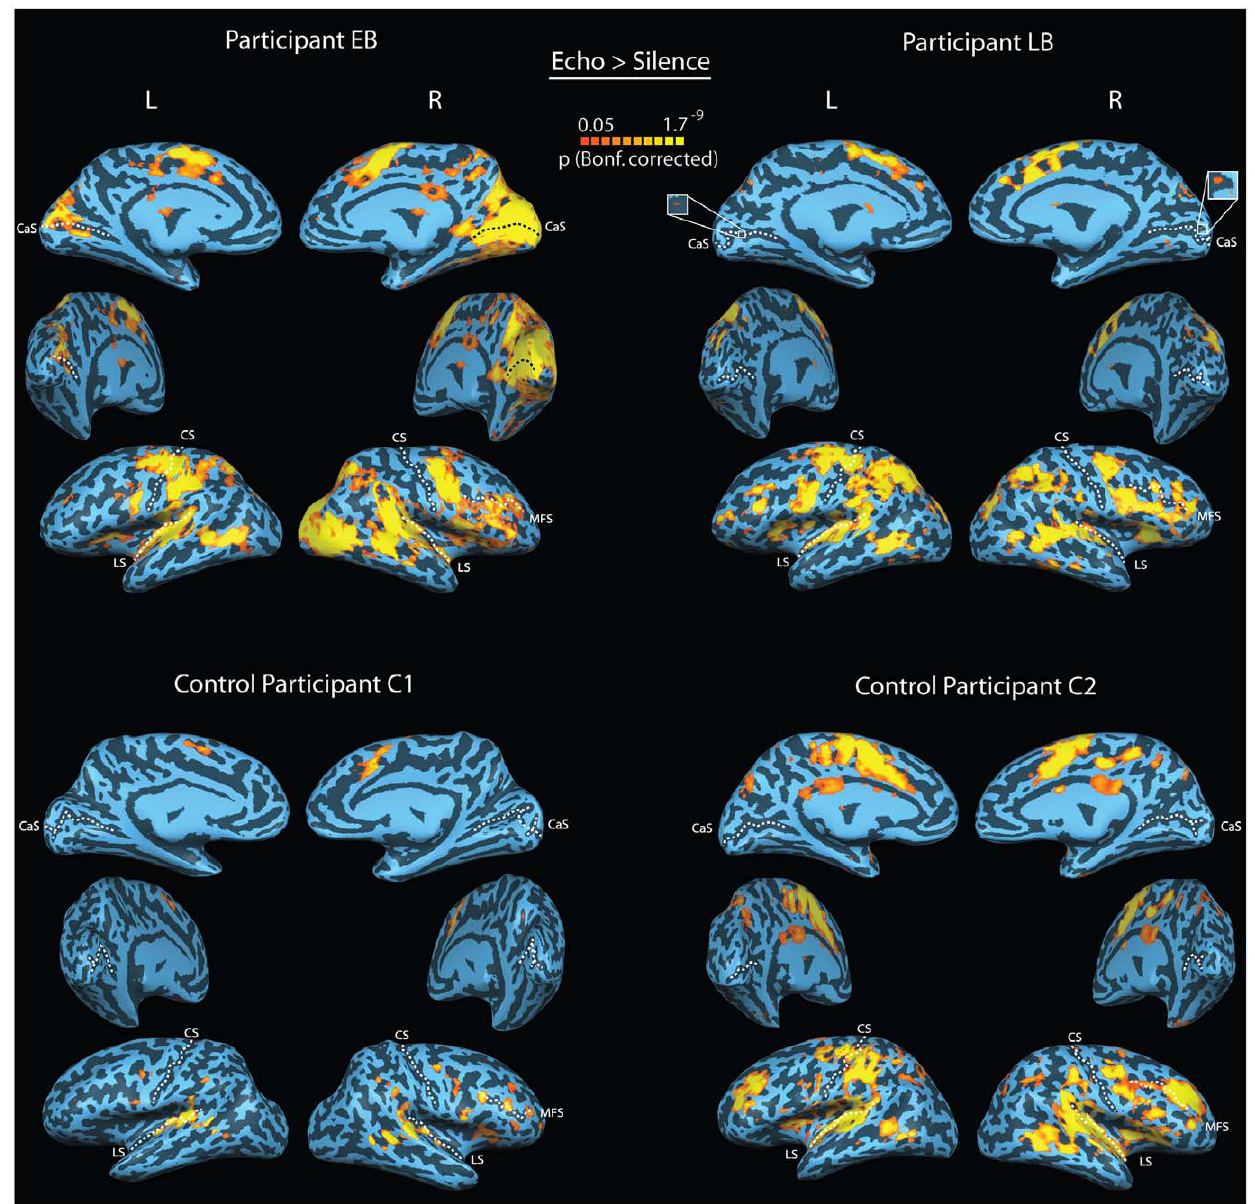
Figure 2. BOLD activity projected on participants reconstructed and partially inflated cortical surface. Concavities and convexities are colored dark and light, respectively. CS-central sulcus, CaS-calcarine sulcus, LS- lateral sulcus, MFS – middle frontal sulcus. Top panel: BOLD activity while EB and LB listened to recordings of their own echolocation sounds that had been made in an anechoic chamber and judged the location (left vs. right), shape (concave vs. flat) or stability (moving vs. stationary) of the sound reflecting surface (see Figure 1F for behavioral results). Bottom Panel: BOLD activity while C1 and C2 listened to recordings they had trained with, i.e. EB and LB’s echolocation sounds, respectively. Just as EB and LB, C1 and C2 judged the location (left vs. right), shape (concave vs. flat) or stability (moving vs. stationary) of the sound reflecting surface (see Figure 1F for behavioral results). Both EB and LB, but not C1 or C2, show reliable BOLD activity in calcarine sulcus, typically associated with the processing of visual stimuli. EB shows more BOLD activity in calcarine sulcus than LB. All subjects (except C2) also show BOLD activity along the central sulcus (i.e. Motor Cortex) of the left hemisphere, most likely due to the response related right-hand button press. All subjects also show BOLD activity in the lateral sulcus (i.e. Auditory Complex) of the left and right hemispheres and adjacent and inferior to the right medial frontal sulcus. The former likely reflects the auditory nature of the stimuli. The latter most likely reflects the involvement of higher order cognitive and executive control processes during task performance. control participants. When we contrasted BOLD activity related to outdoor recordings that contained click echoes with those that did not, neither C1 nor C2 showed any differential activation in any region of their brains (Figure 3, bottom). The results also hold at a more liberal statistical threshold (Figure S2).